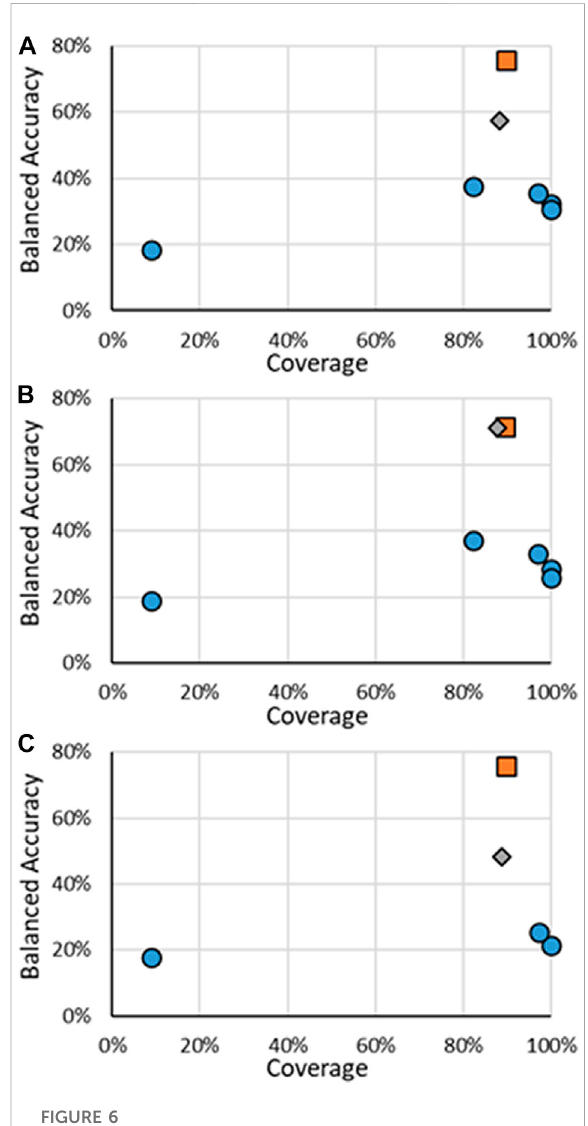
FIGURE 6 BA vs. coverage for AR multi-class models tested in this work for (A) binding, (B) agonism, and (C) antagonism. Orange squares are for RF models when all substances are considered, gray diamonds are when only the substances in the RF test substances are considered, and blue circles are for other